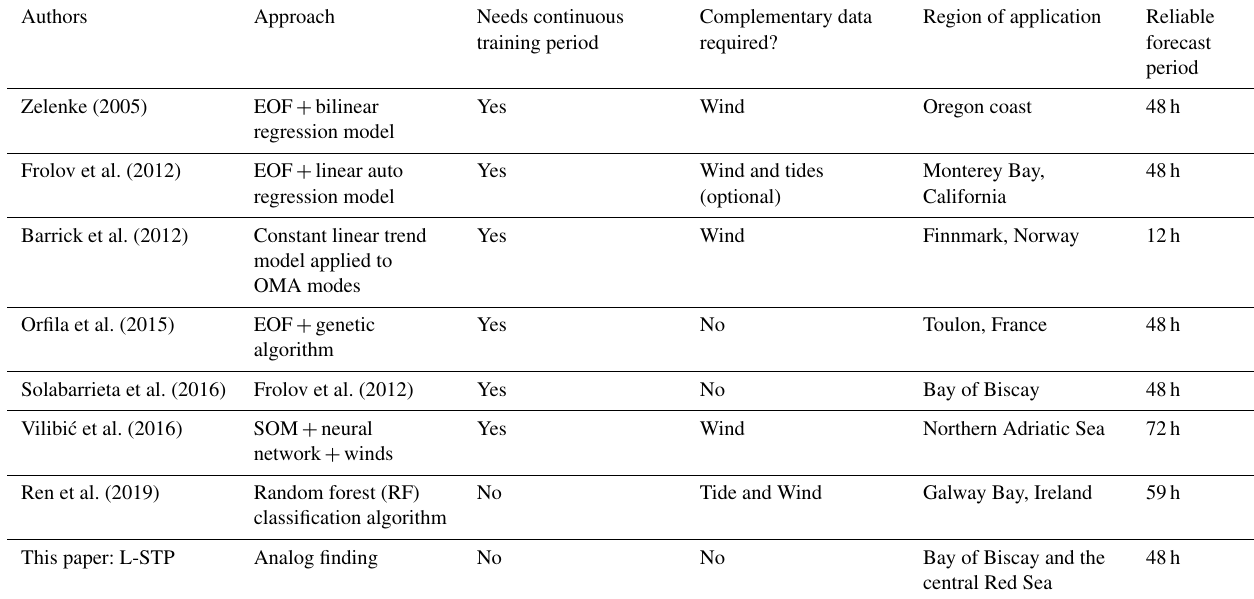
Table 1. Characteristics of the previously developed STP works based on HFR